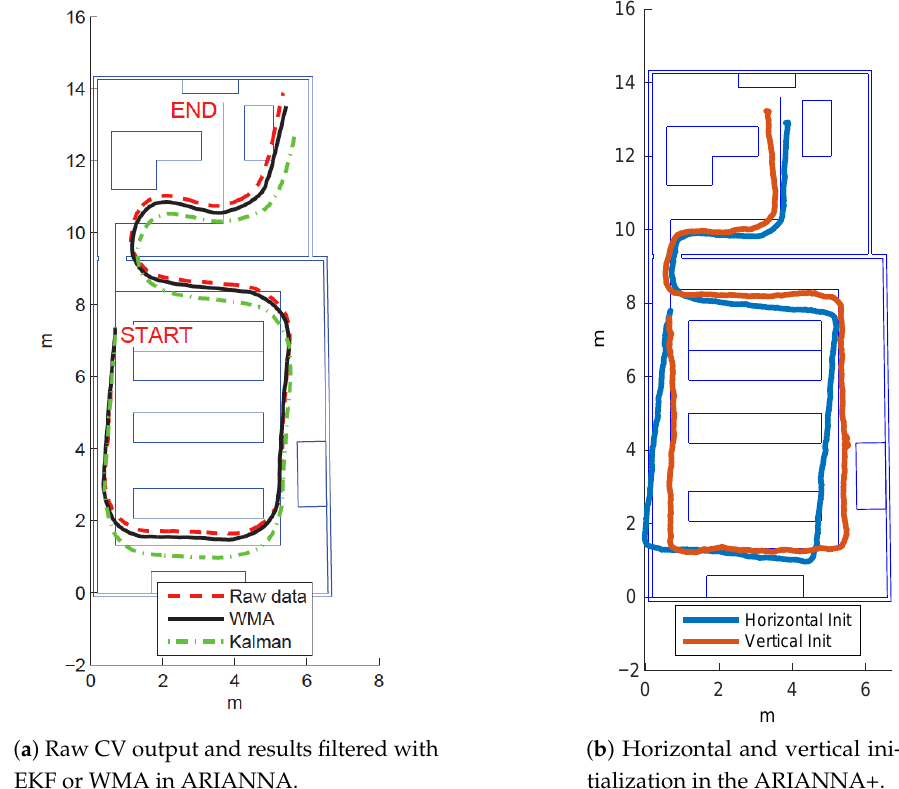
Figure 6. Tracking performance comparison using the previous ARIANNA system ( a ) or the proposed ARIANNA+ system ( b ) using different configuration